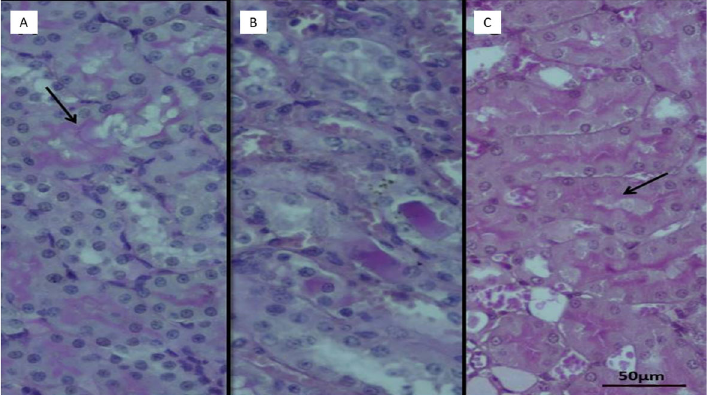
Figure 7. Sections showing normal brush borders (arrows) in proximal tubular epithelial cells in A, healthy control group and in C, isoniazid + rifampicin + lycopene group (H&E). B , Section showing brush border loss due to tubular damage in isoniazid + rifampicin group (PAS staining). Scale bar 50 m